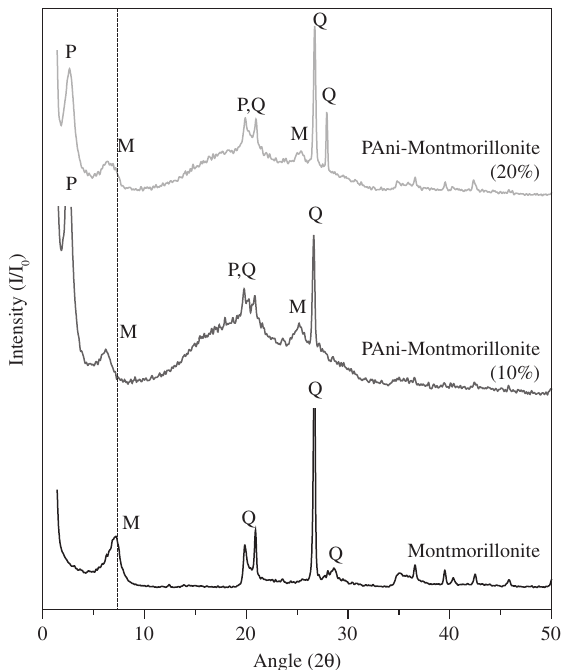
Figure 3. XRD patterns of montmorillonite and composites synthesized with different amounts of mineral clay.